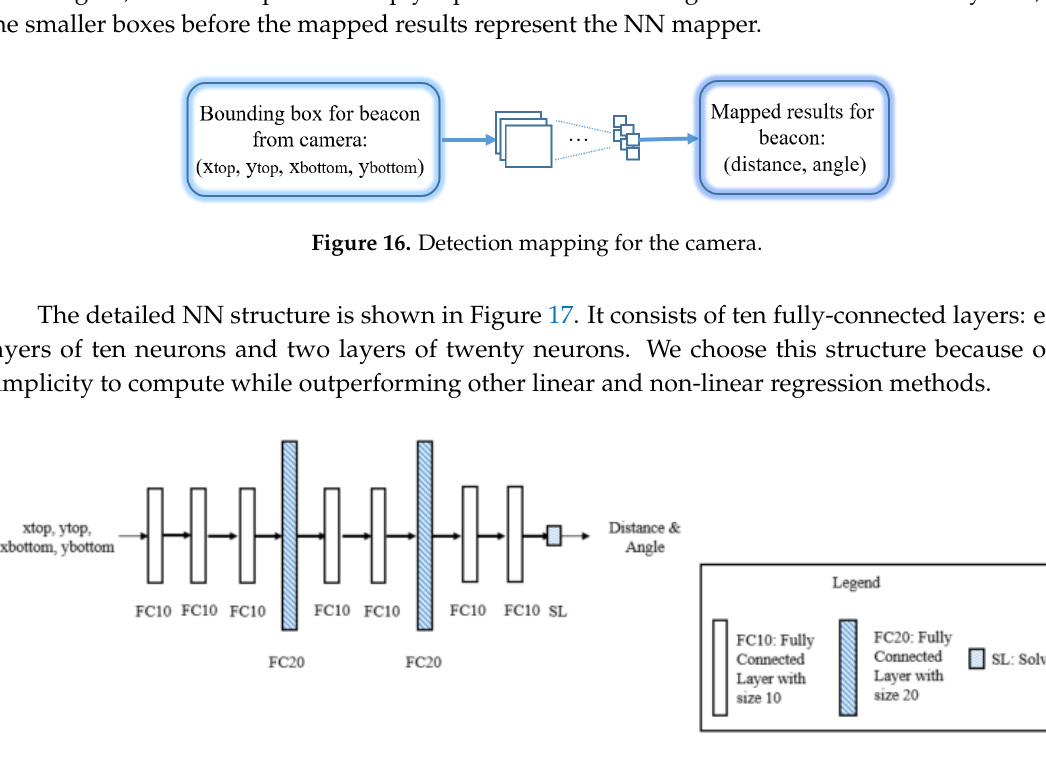
Figure 17. NN structure for detection mapping for the